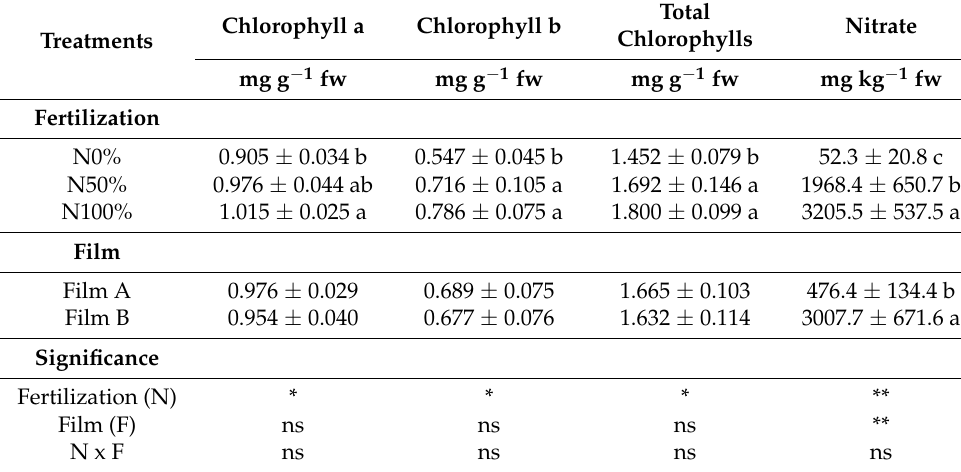
Table 3. Effect of N fertilization (not fertilized = N0%; fertilized with 25 kg N ha − 1 = N50%; fertilized with 50 kg N ha − 1 = N100%) and plastic film (clear plastic film = Film A; light diffusion